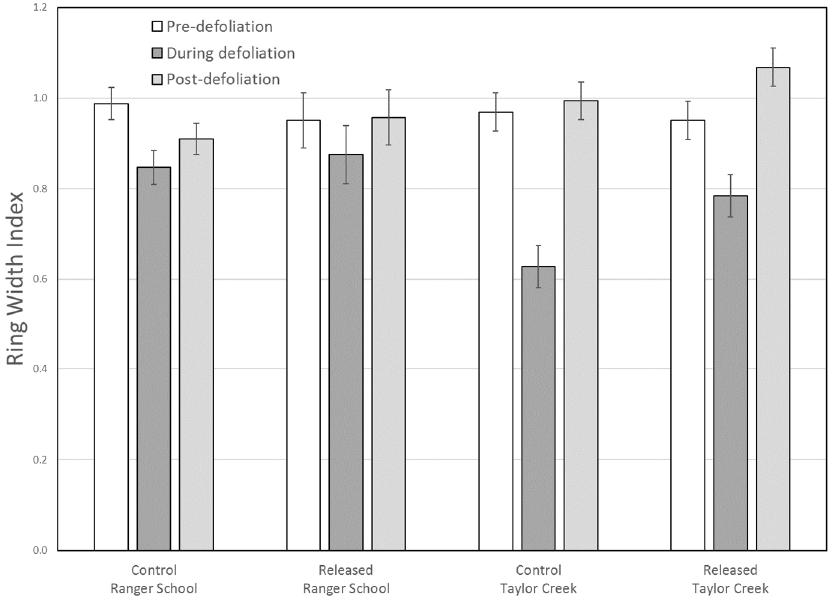
Figure 7. Mean ring width index by site and treatment for 4 years pre-defoliation, 2–3 years during defoliation, and 4 years post-defoliation.